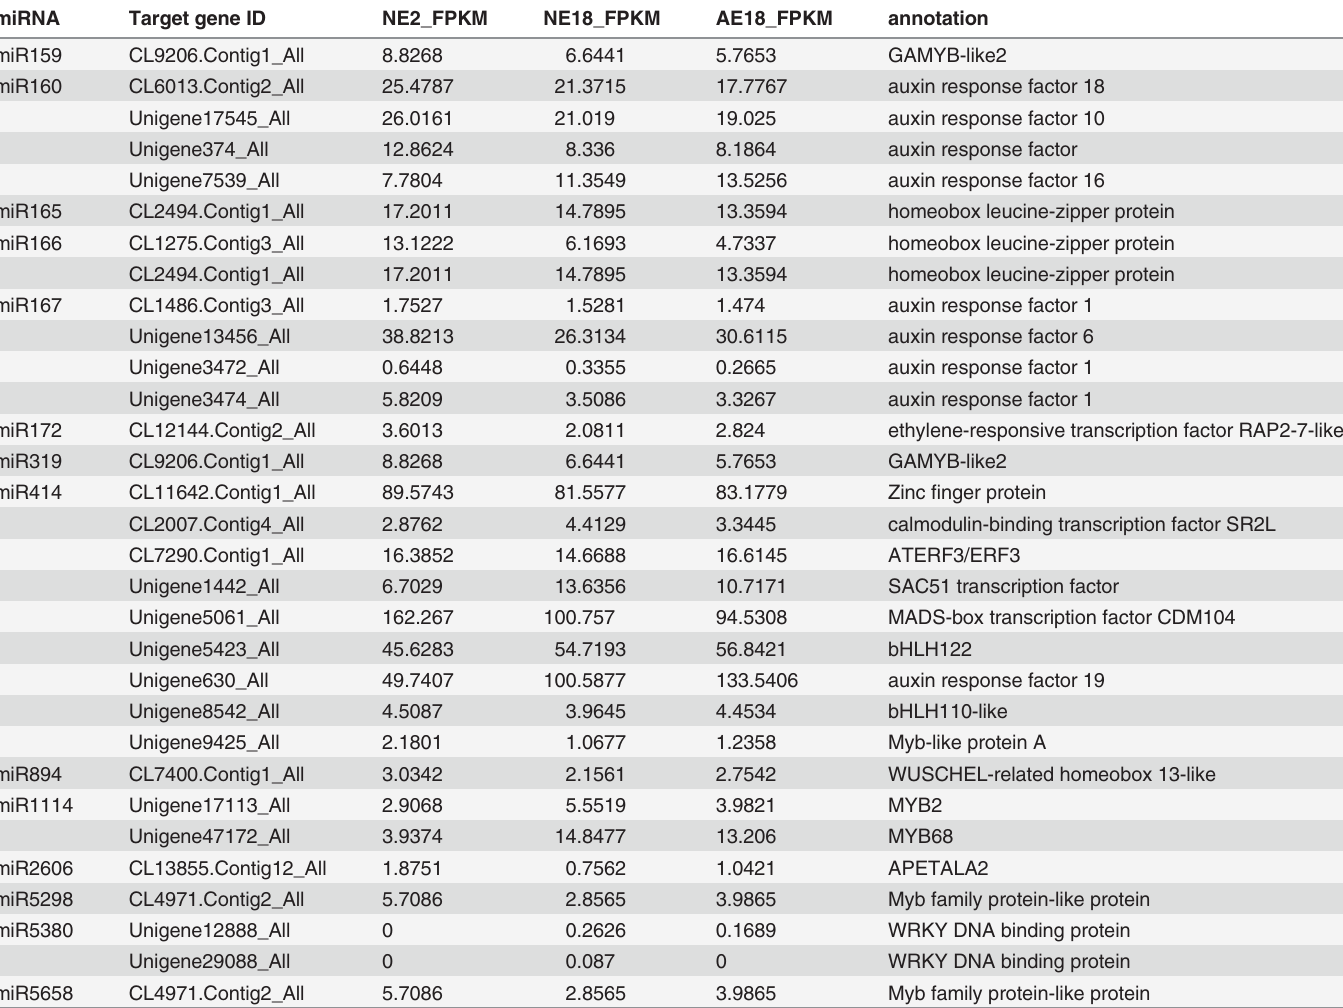
Table 3. Identified candidate transcription factor targets of miRNAs during chrysanthemum embryogenesis. miRNA Target gene